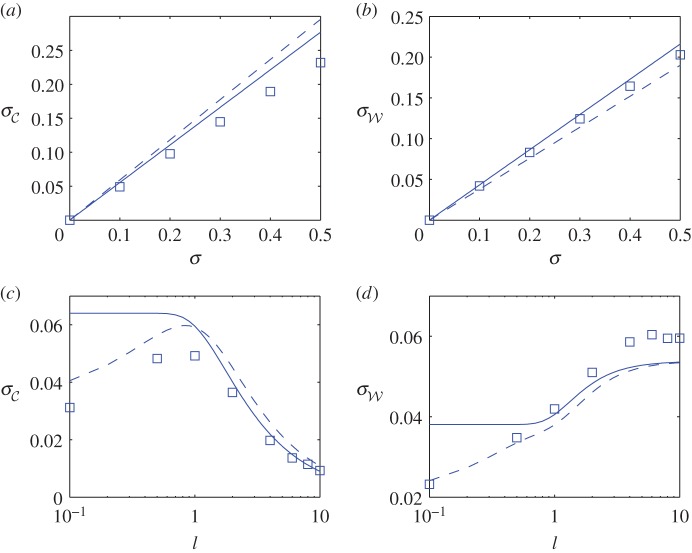
The effect of variance σ on the standard deviation (a,b) of drop centre C and width W, respectively, at T=100, for l=1, η=10−3 and Pe=105. Squares represent results from the PDE model (2.1); solid lines represent results from the weak disorder approximation (4.35) and dashed lines represent results from the linearized wedge model (5.7). Panels (c,d) show corresponding dependence on the correlation length l for σ=0.1. (Online version in colour.)